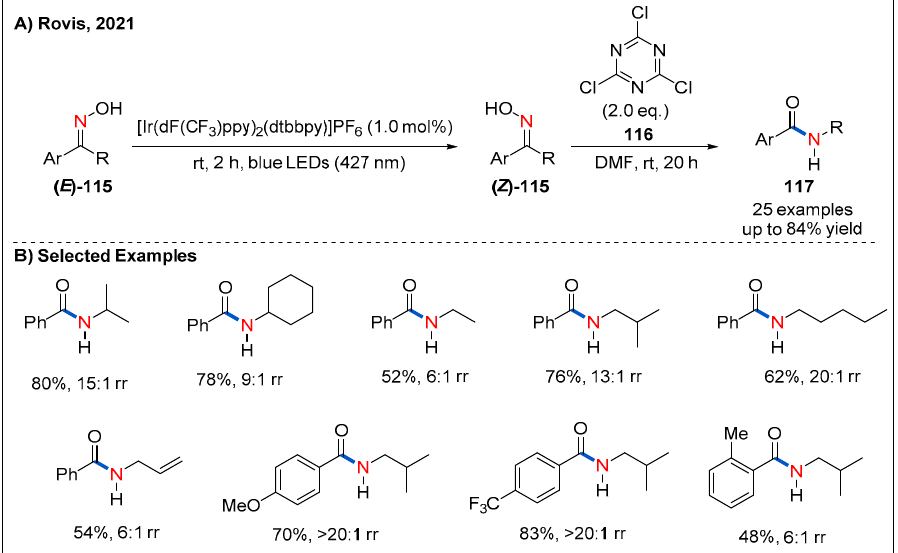
Figure 35. Visible-light-promoted nonclassical Beckmann rearrangement.